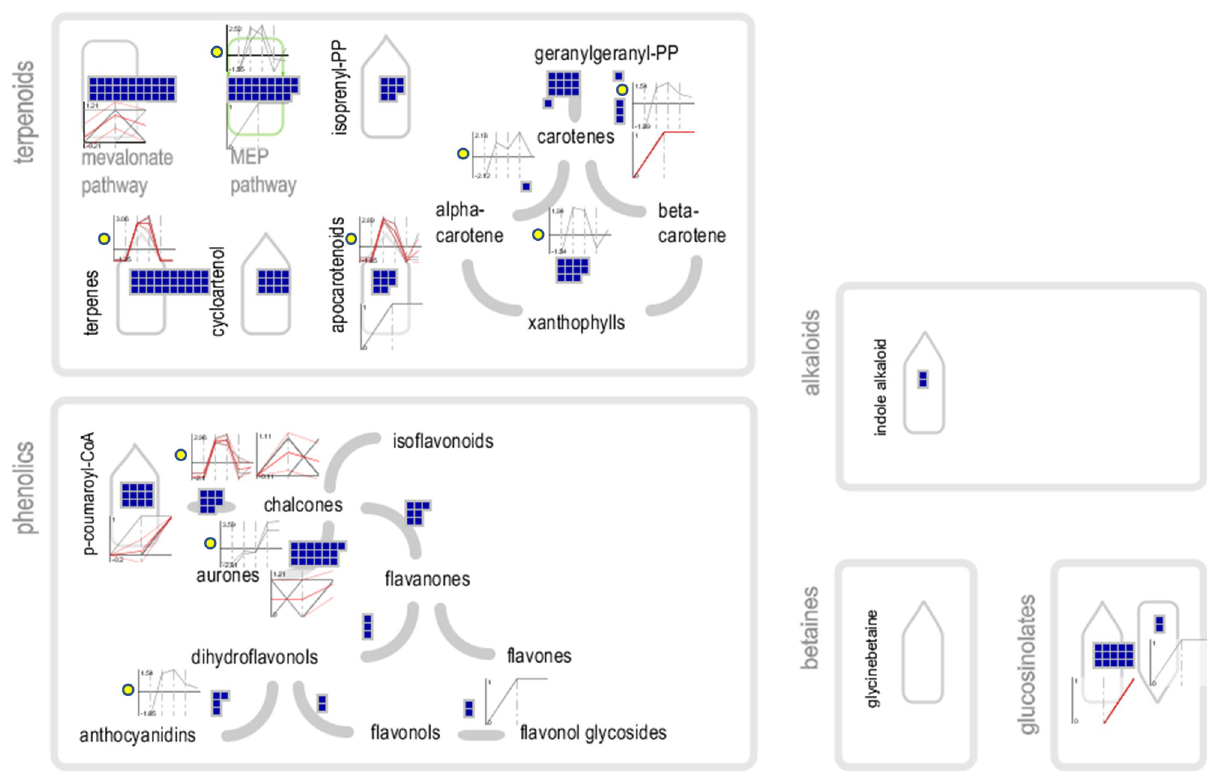
Fig 5. Overview of secondary metabolism. Blue squares indicate assembled transcripts. The 6-point line graphs with a yellow circle next to them are plots of differentially expressed transcripts in duplicate for the corm, leaf and flower tissues with log 2 (FPKM +1) on the vertical axis. The 3-point line graphs that are not otherwise marked, represent the qualitative detection of proteins in the corm, leaf and flower tissues.